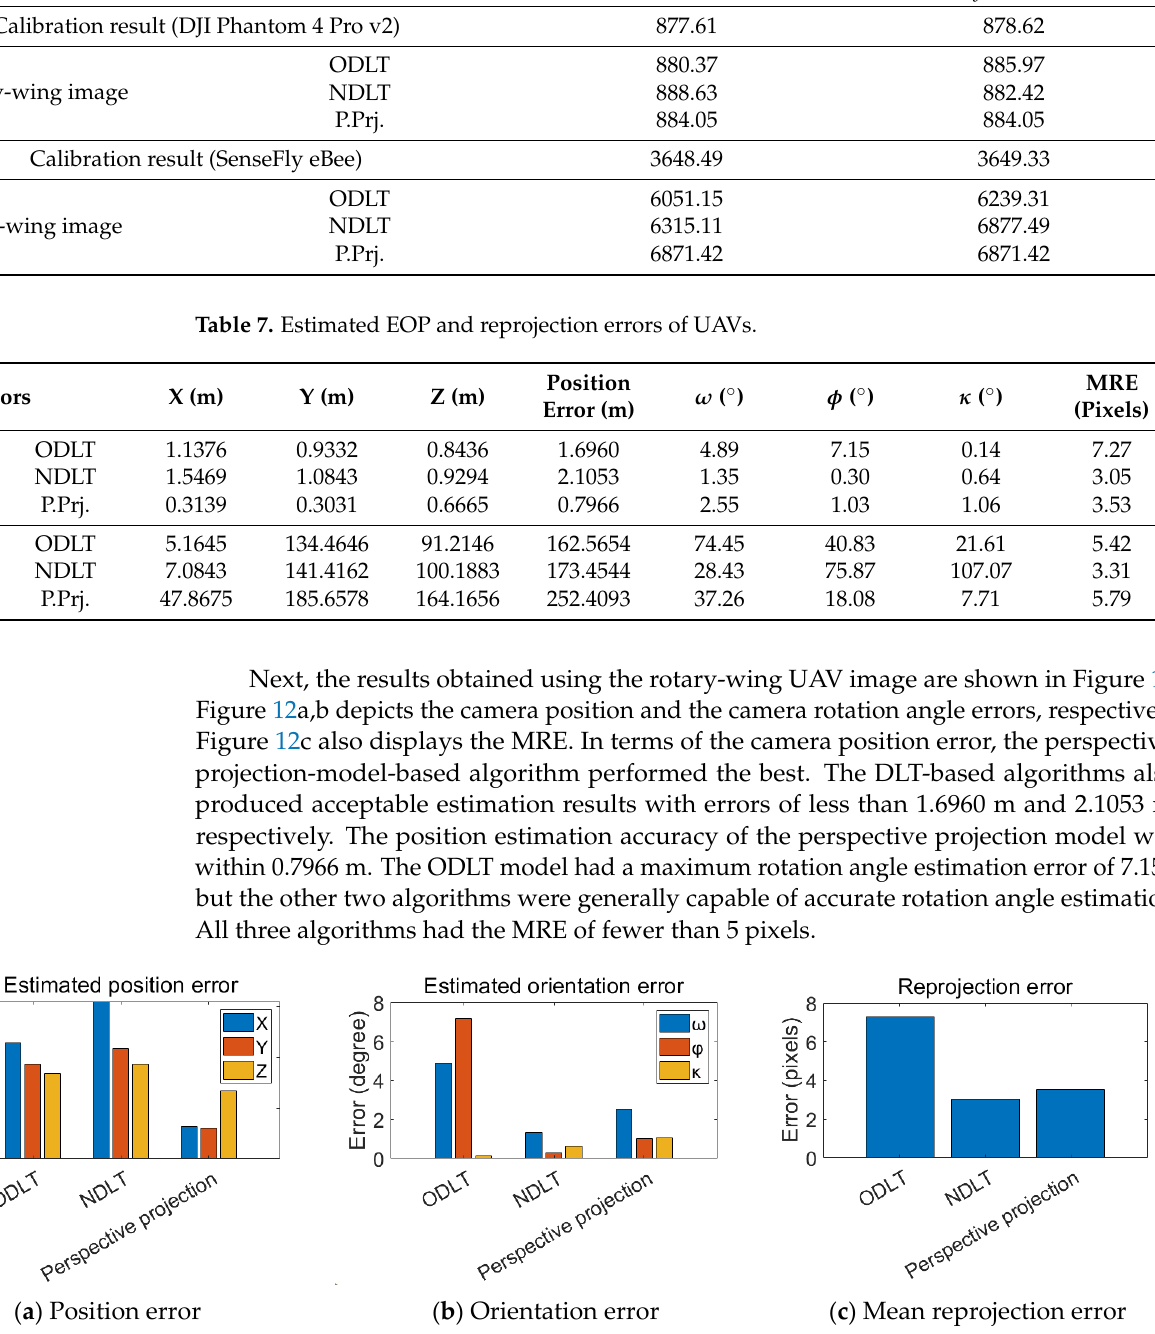
Table 6. Calibration result and estimated principal distance of UAVs.